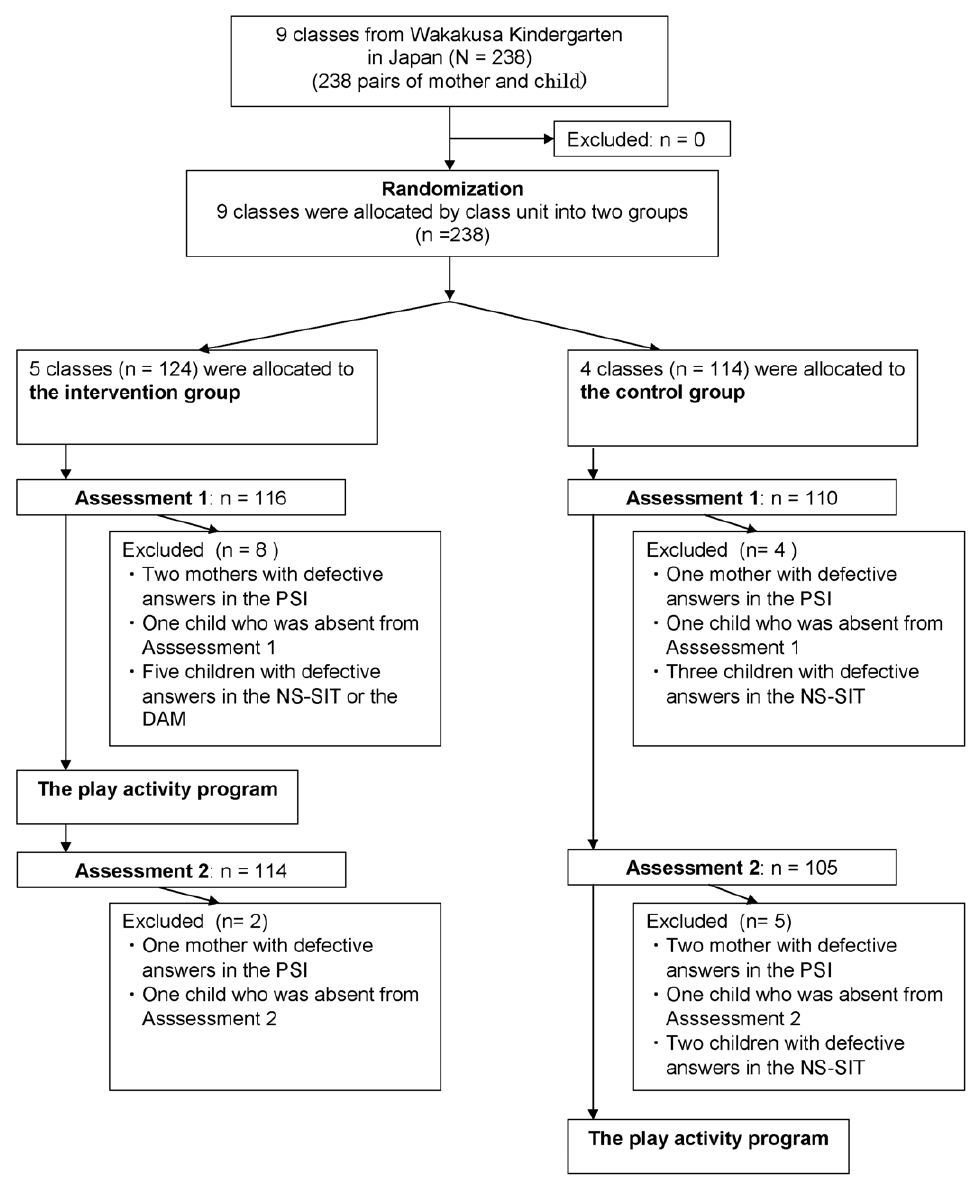
Figure 1. Trial profile.